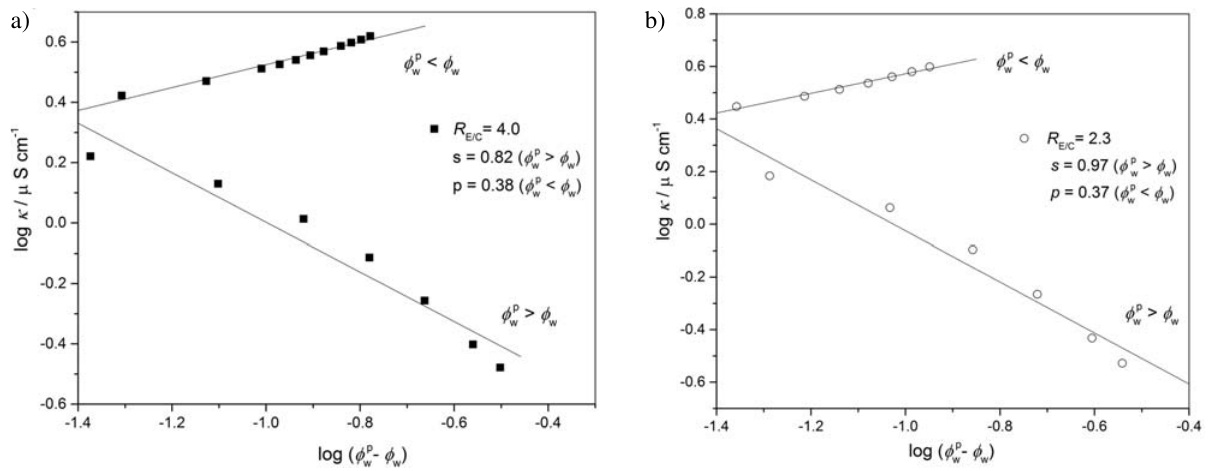
Figure 4. The scaling dependence of the conductivity, along the dilution line R p – φ log( φ ). The lines are the scaling fit of the data below and above φ w w